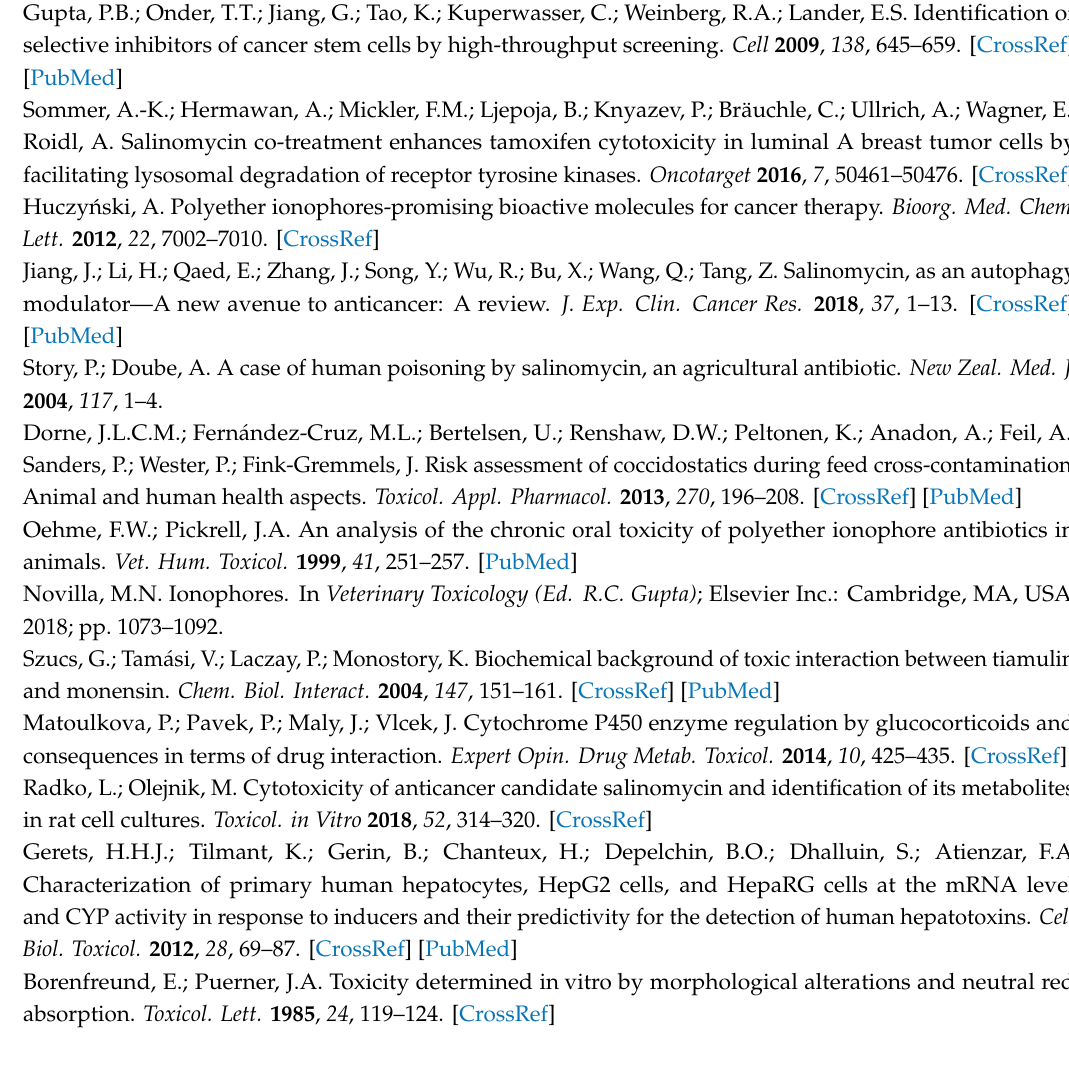
Supplementary Materials: The following are available online, Figure S1: The cytotoxicity of salinomycin (SAL) and its combination with tiamulin (T) or prednisolone (P) at concentration 1 µ g / mL after 12 and 24 h exposure of PHH. Results were calculated as the percent of solvent control (mean ± SD) ( n = 3, independent experiments). Statistical significance was evaluated by ANOVA and Dunnet’s post-test * p ≤ 0.05. # p ≤ 0.01 and p ≤ 0.001. Triton X was a positive control. Figure S2: The cytotoxicity of salinomycin (SAL) and its combination with tiamulin at concentration 1 µ g / mL (T1) and 10 µ g / mL (T10) or prednisolone at concentration 1 µ g / mL (P1) after 24 and 48 h exposure of HepG2 cells. Results were calculated as the percentage of solvent control (mean ± SD) ( n = 3, independent experiments). Statistical significance was evaluated by ANOVA and Dunnet’s post-test * p ≤ 0.05, # p ≤ 0.01, and p ≤ 0.001. Triton X was a positive control. Figure S3: The cytotoxicity of salinomycin (SAL) and its combination with tiamulin at concentration 1 µ g / mL (T1) and 10 µ g / mL (T10) or prednisolone at concentration 1 µ g / mL (P1) after 24 and 48 h exposure of fibroblasts (Balb / c 3T3). Results were calculated as the percentage of solvent control (mean ± SD) ( n = 3, independent experiments). Statistical significance was evaluated by ANOVA and Dunnet’s post-test * p ≤ 0.05, # p ≤ 0.01, and p ≤ 0.001. Triton X was a positive control. Figure S4: Selected Reaction Monitoring chromatograms of potential salinomycin metabolites in medium of PHH exposed to salinomycin at the concentration of 25 µ g / mL for 24